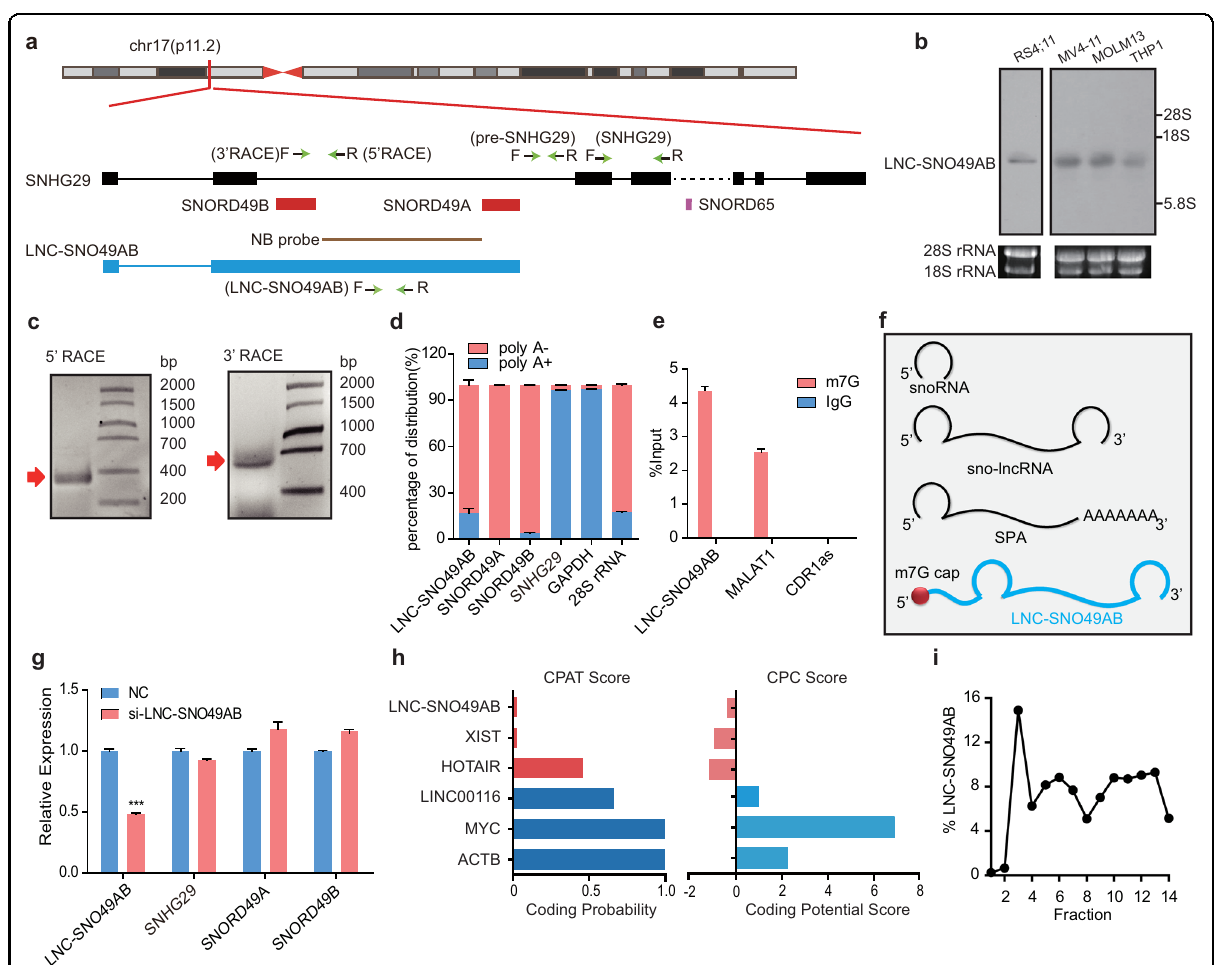
Fig. 1 Characterization of LNC-SNO49AB in leukemia. a The schematic of SNORD49AB gene locus. Top: chr17(p11.2) locus; Middle: the schematic represents SNHG29, SNORD65 and SNORD49A/B. Bottom: Physical map depicts LNC-SNO49AB gene locus. The qRT-PCR and RACE primer were designed as indicated (green arrow). The probe used for northern blotting (NB) is also shown. b Northern blot analysis of LNC-SNO49AB expression in total RNA obtained from four leukemia cell lines. Representative results are shown from three replicates. c Agarose gel electrophoresis analysis of 5 ′ (right) and 3 ′ RACE (left) for cDNA generated from RS4;11 cells. Representative results are shown from three replicates. d Poly(A) + and poly(A) – RNAs were extracted from RS4;11 cells and subjected to RT-qPCR analysis. LNC-SNO49AB, SNORD49A and SNORD49B were enriched in the poly(A) – fraction. SNHG29 is polyadenylated. GAPDH and 28 S rRNA were used as controls for poly(A) + and poly(A) – RNAs, respectively. Error bars represent SEM in triplicate experiments. e RNA immunoprecipitation (RIP) using an anti-m7G cap antibody and IgG followed by RT-qPCR analysis showed that LNC-SNO49AB is capped by m7G. MALAT1 and circular RNA CDR1as were used as the controls for m7G capped positive and negative RNA, respectively. Error bars represent SEM in triplicate experiments. f Schematic representation of snoRNAs and two known kinds of snoRNA-related lncRNAs, including sno-lncRNA and SPA. LNC-SNO49AB represents a novel kind of snoRNA-related lncRNA with a m7G cap and snoRNA end. g Expression levels of LNC-SNO49AB, SNHG29 and SNORD49AB after knockdown of LNC-SNO49AB by siRNAs. Data were normalized to GAPDH mRNA. * P < 0.05, ** P < 0.01, and *** P < 0.001 by Student ’ s t -test. Error bars represent SEM of the means. h Scores of LNC-SNO49AB and other known coding and noncoding RNAs as determined by analysis with CPAT (http://lilab.research.bcm.edu/) and CPC (http://cpc.cbi.pku.edu.cn). i Sucrose sedimentation analysis of RNA levels from each fraction of MOLM13 cells as measured by RT-qPCR. Relative levels of LNC-SNO49AB , ACTB (mRNA) and HY1 (noncoding RNA) are shown for each collected